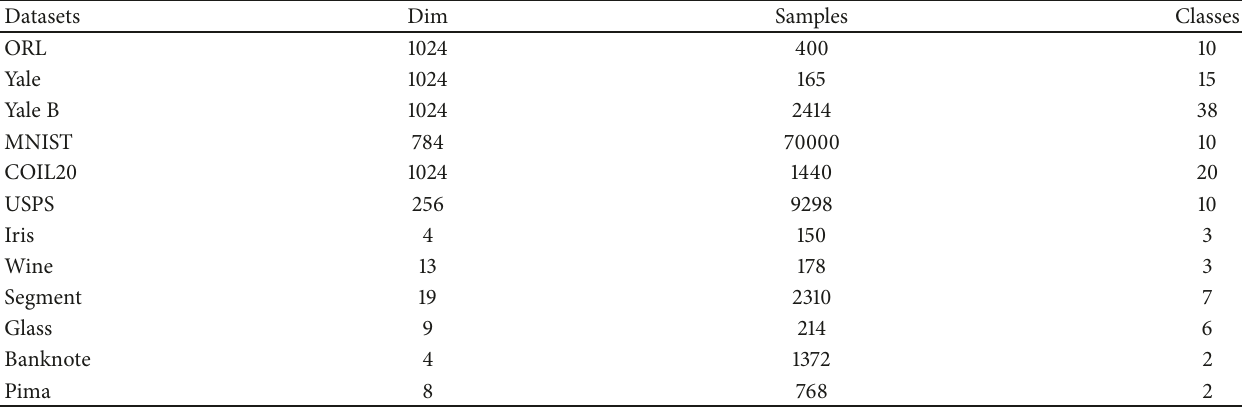
Table 1: Dataset descriptions Dim is the number of feature dimensions, Samples is the number of data points, and Classes is the number of classes.